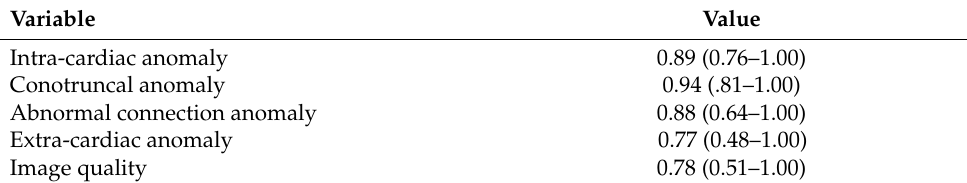
Table 7. Inter-reader agreement for the cardiac CT